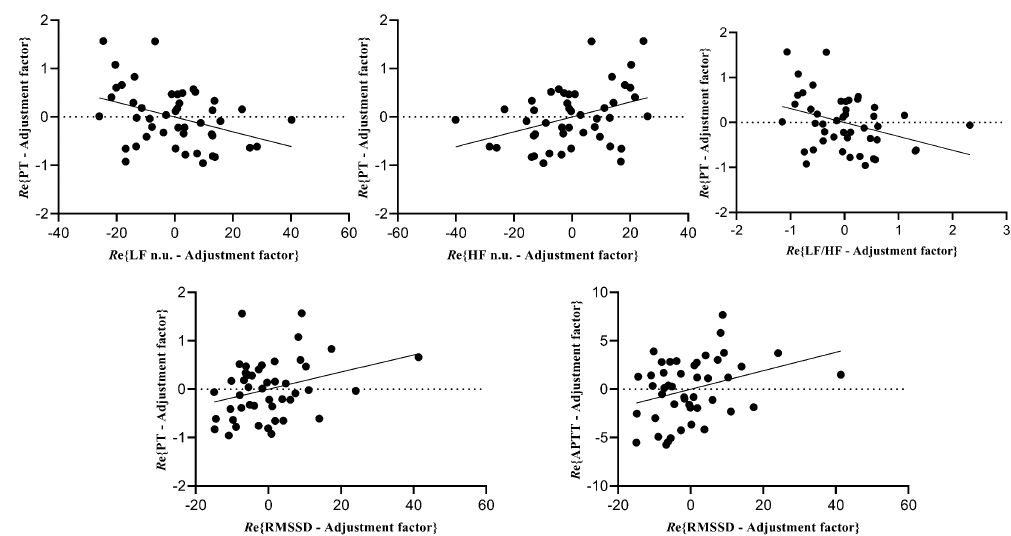
Figure 2. Partial correlation plots of the relationship between RCIs (PT and APTT) and HRV parameters (RMSSD, LF n.u., HF n.u., and LF/HF). Re{y ∼ x} indicates the residuals of regressing y against